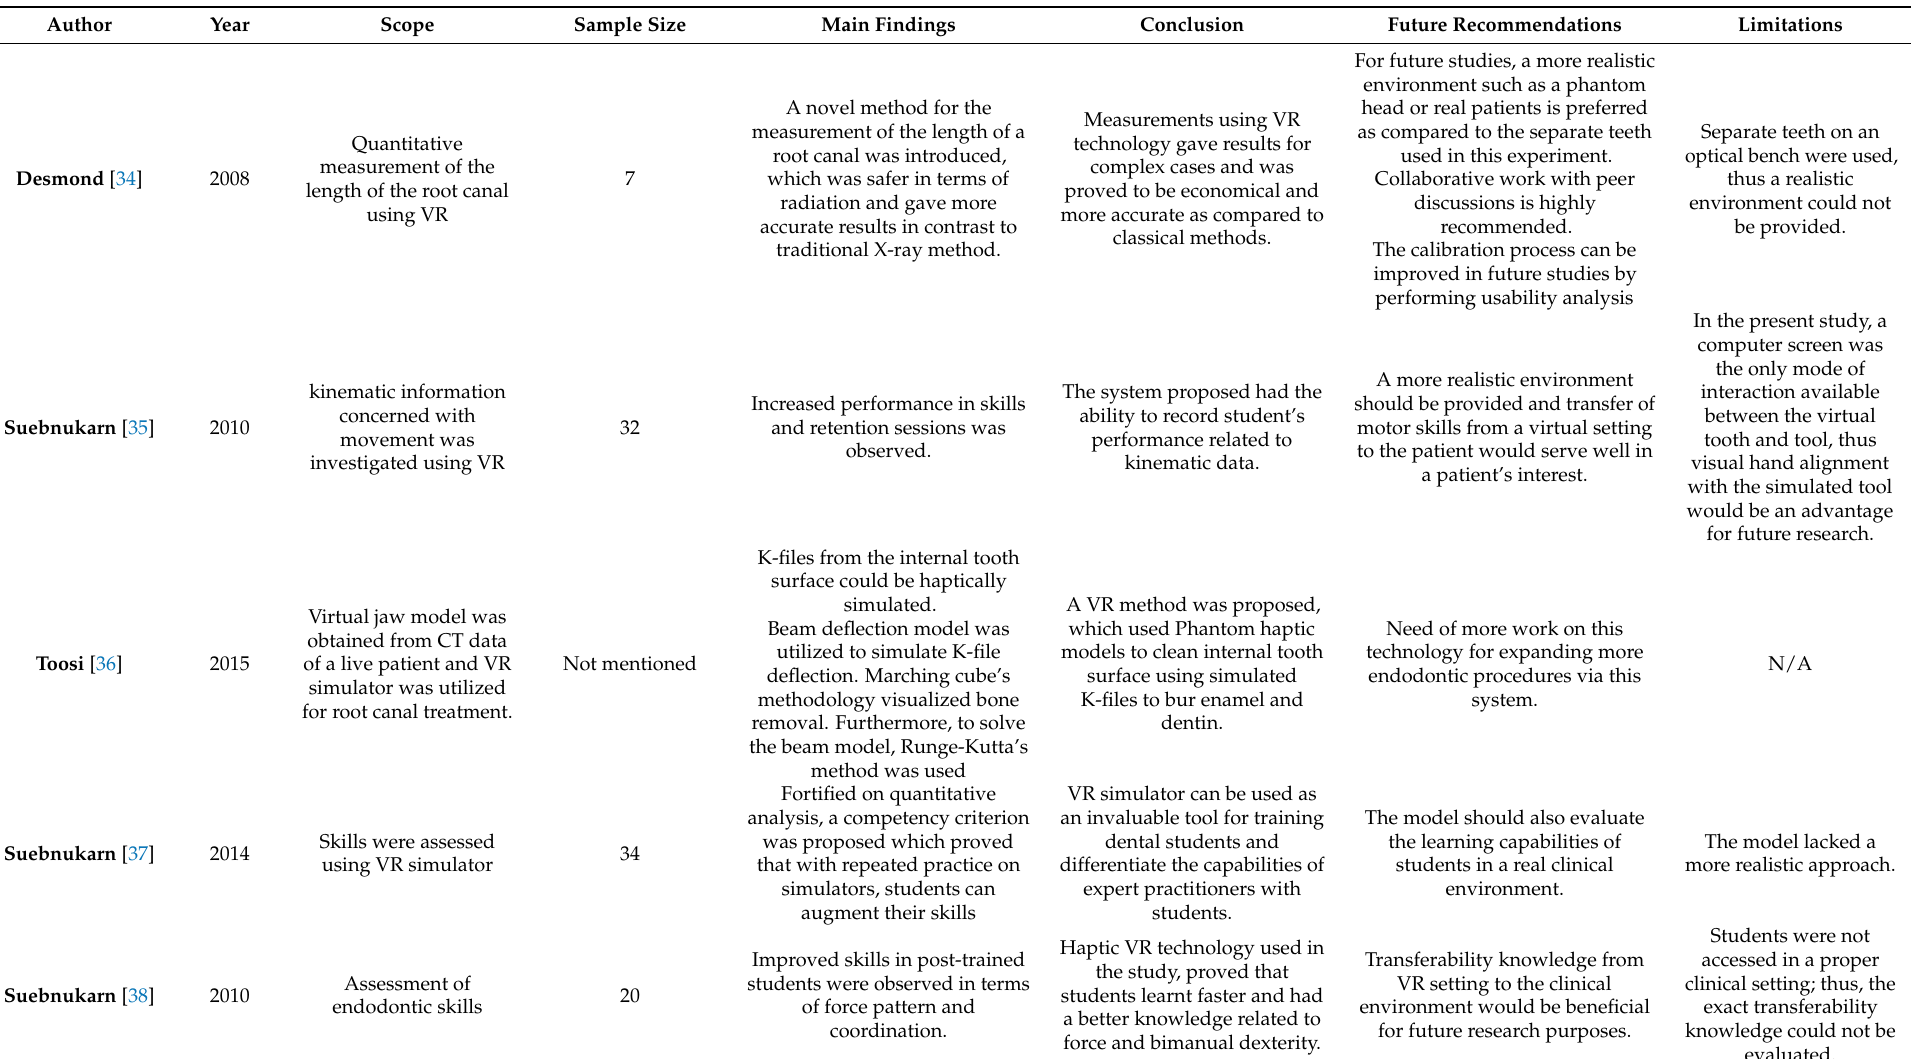
Table 3. Application of virtual reality (VR) simulation education in the restorative dentistry and